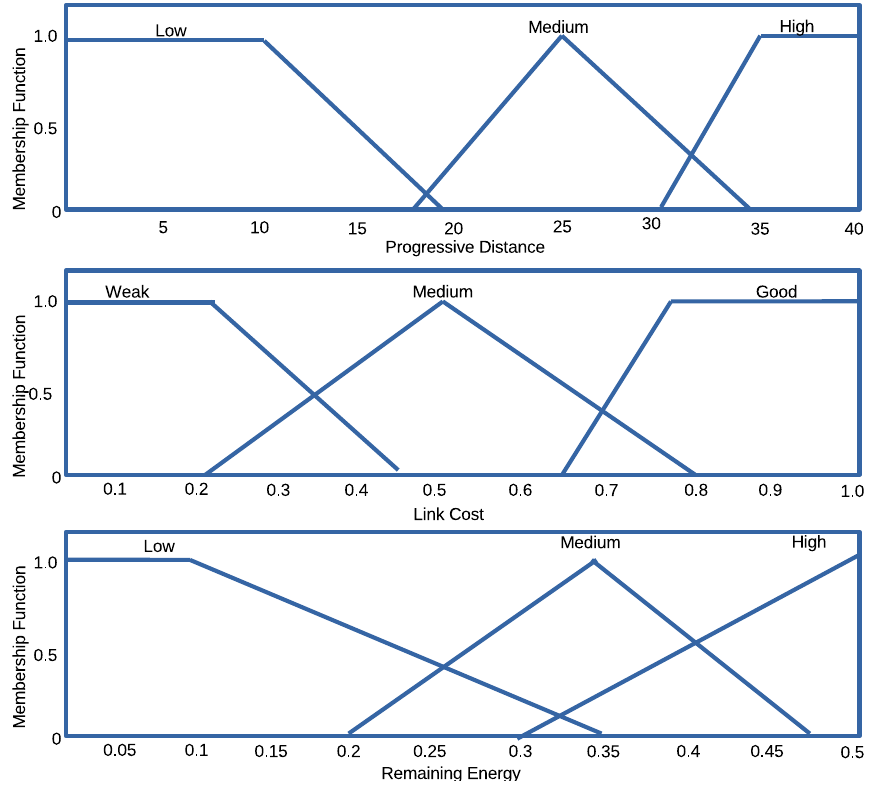
Figure 4. Fuzzy input membership